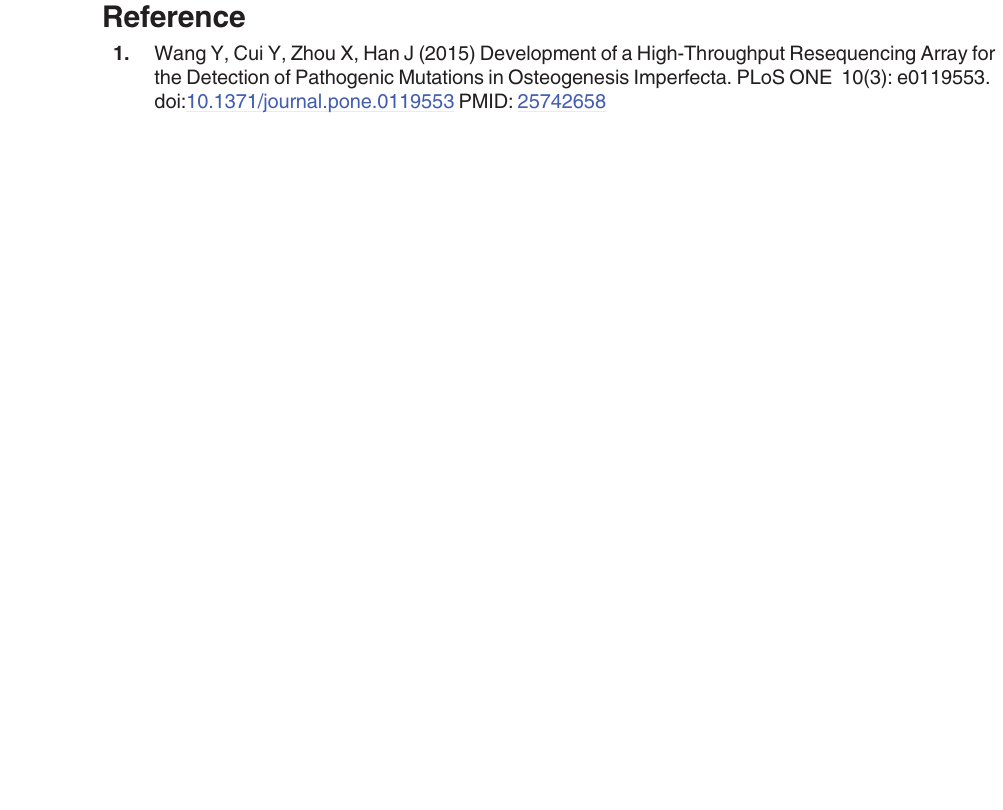
The variant in patient 4, c.1135G > A, p.Gly379Arg in COL1A2 , reported to be in exon 24 ac- tually lies in exon 21. The variant in patient 7, c.937-3C > T in COL1A2 , reported to be in intron 19 actually lies in intron 18. Sources for the sequence files in S3 Supplementary data information can be found online in the Ensembl database: http://www.ensembl.org/index.html as well as the Osteogenesis Imper- fecta Variant Database: https://oi.gene.le.ac.uk/home.php